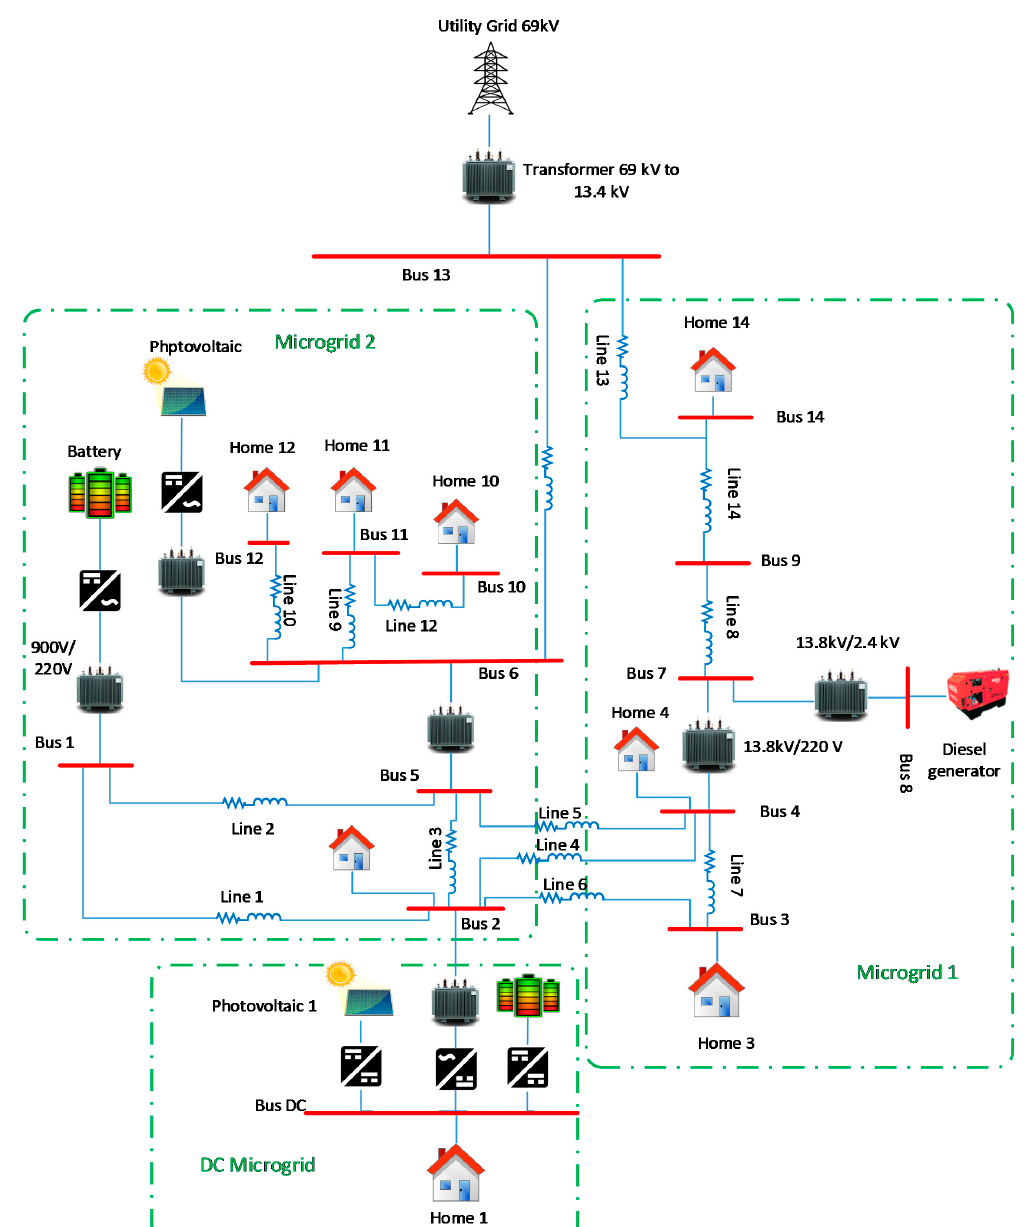
Figure 1. The proposed hybrid microgrids system structure.